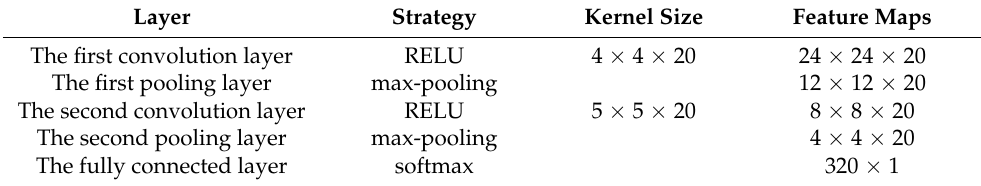
Table 2. The parameters for the CNN.